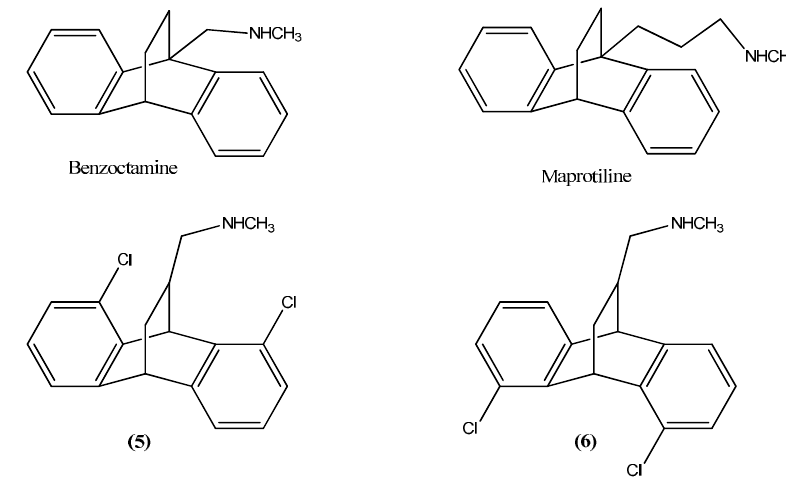
Figure 1. Benzoctamine, maprotiline and targeted analogues.